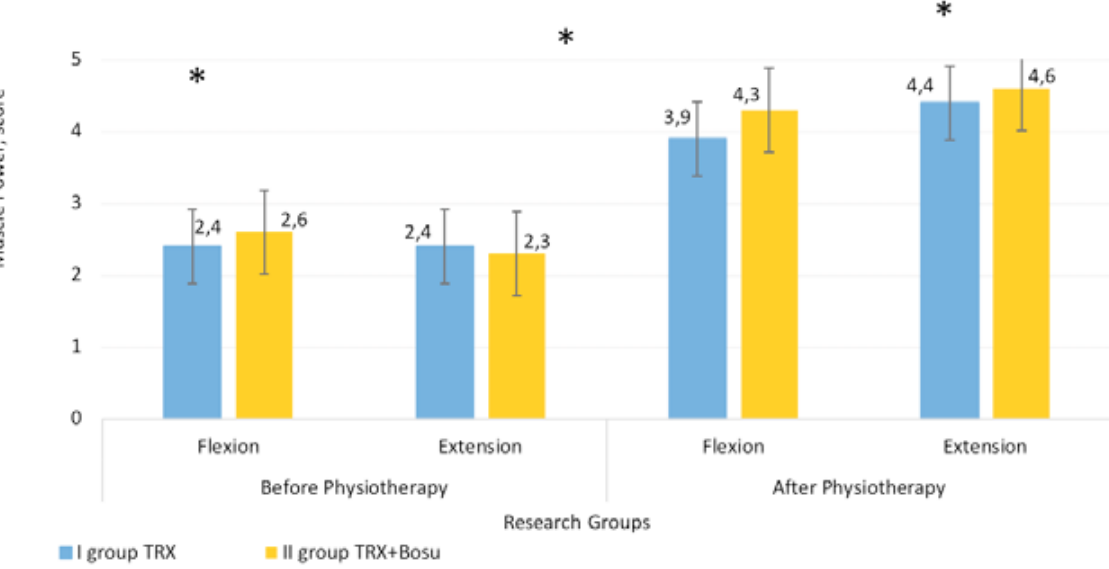
Fig. 1. Research subjects’ knee flexor and extensor muscles power. Statistical significance, p<0.05 (*).